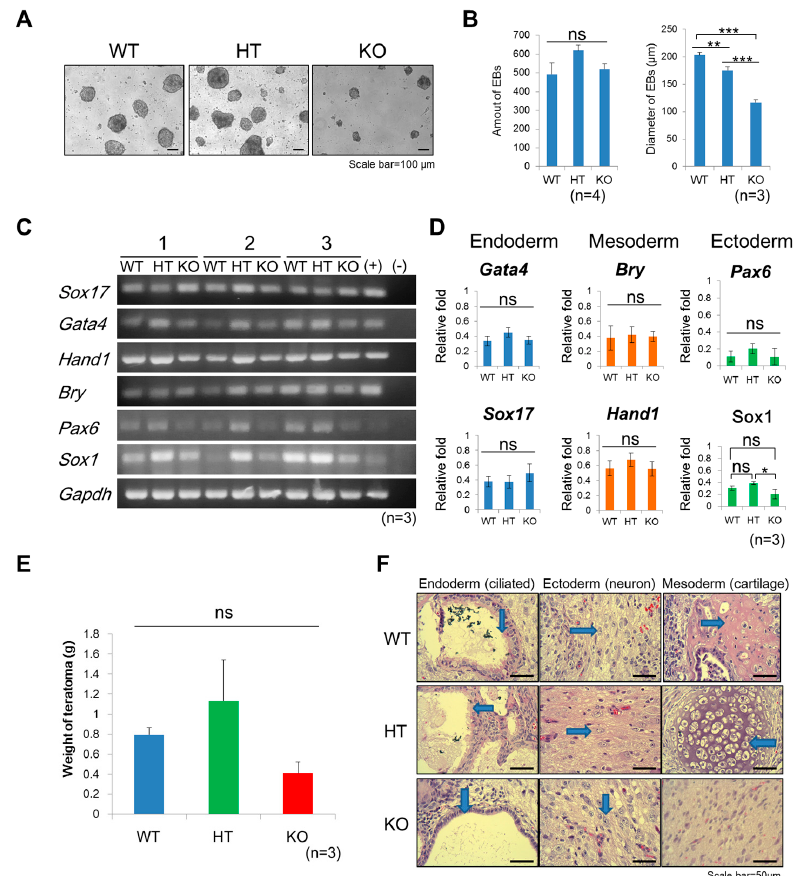
Figure 2. Decreased size of embryoid bodies (EBs) and loss of cartilage cells in teratomas from Terc − / − ntESCs. ( A ) Morphology of EBs derived from Terc +/+ (WT), Terc +/ − (HT), and Terc − / − (KO) ntESCs. Spontaneous differentiation is performed in ESC medium without leukemia inhibitory factor (LIF). ( B ) Formation efficiency and diameter of EBs derived from three genotype s of ntESC. The size of EBs from Terc − / − is significantly smaller than other genotypes (triplicate experiments). ns = no significance. ** = p < 0.005, *** = p < 0.001. ( C ) Detection of three germ layers markers in EBs. Endoderm markers: SRY (Sex-Determining Region Y)-Box 17 ( Sox17 ) and GATA binding protein 4 ( Gata4) . Mesoderm markers: Brychury (Bry) and heart and neural crest derivatives expressed 1 ( Hand1 ). Ectoderm markers: paired box 6 ( Pax6 ) and SRY (Sex-Determining Region Y)-Box 1 ( Sox1 ).